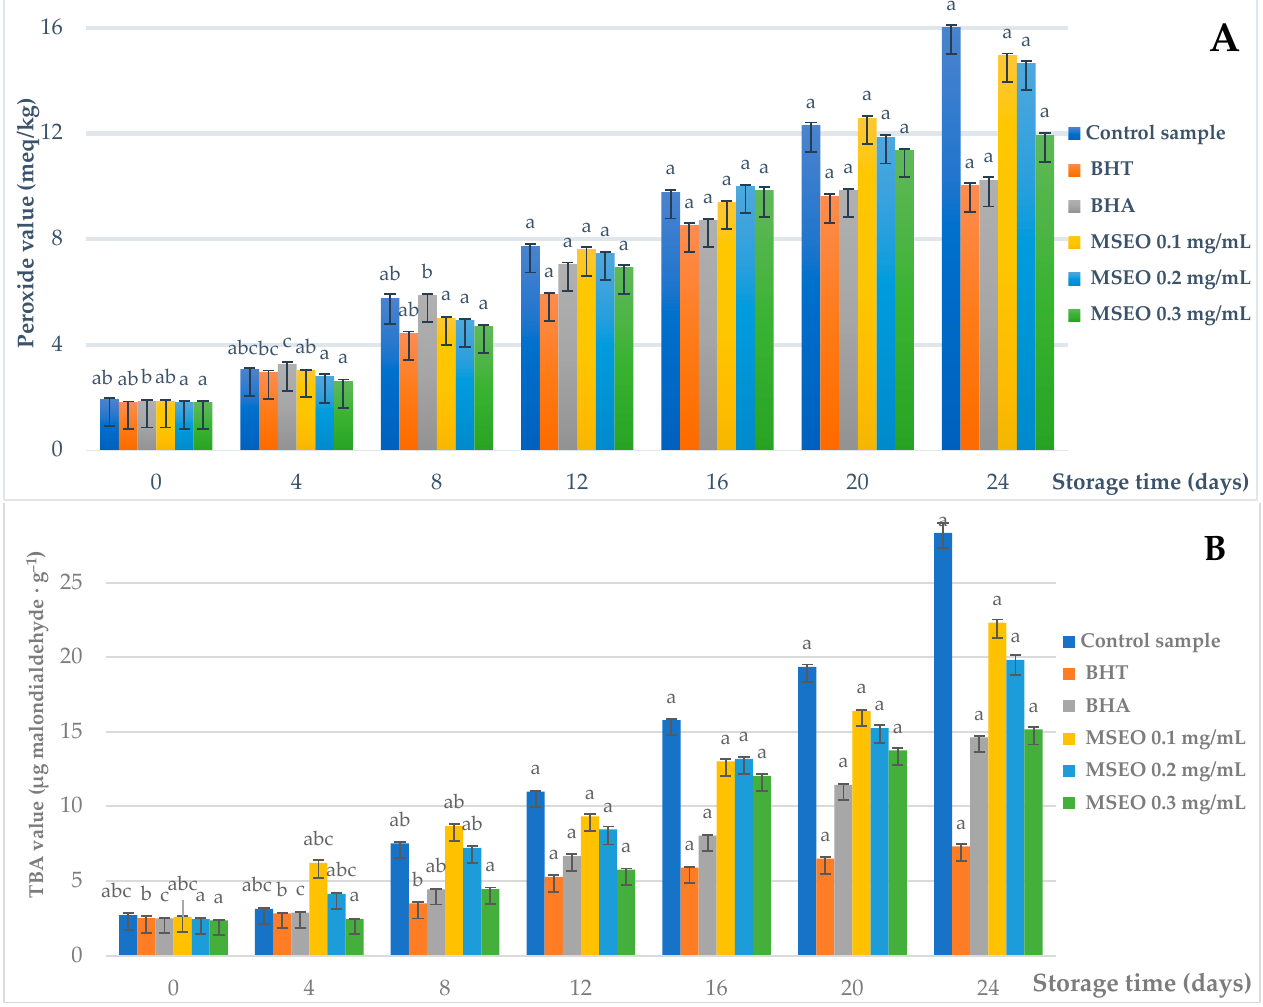
Figure 1. The effect of Mentha × smithiana essential oil (MSEO), butylated hydroxyanisole (BHA), and butylated hydroxy- toluene (BHT) on peroxide values (PVs) ( A ) and thiobarbituric acid (TBA) values, ( B ) of cold-pressed sunflower oil during 24 days of the storage period. Values are the mean, and the error bars indicate standard deviations. Letters indicate ho- mogenous groups within incubation periods ( p > 0.05).